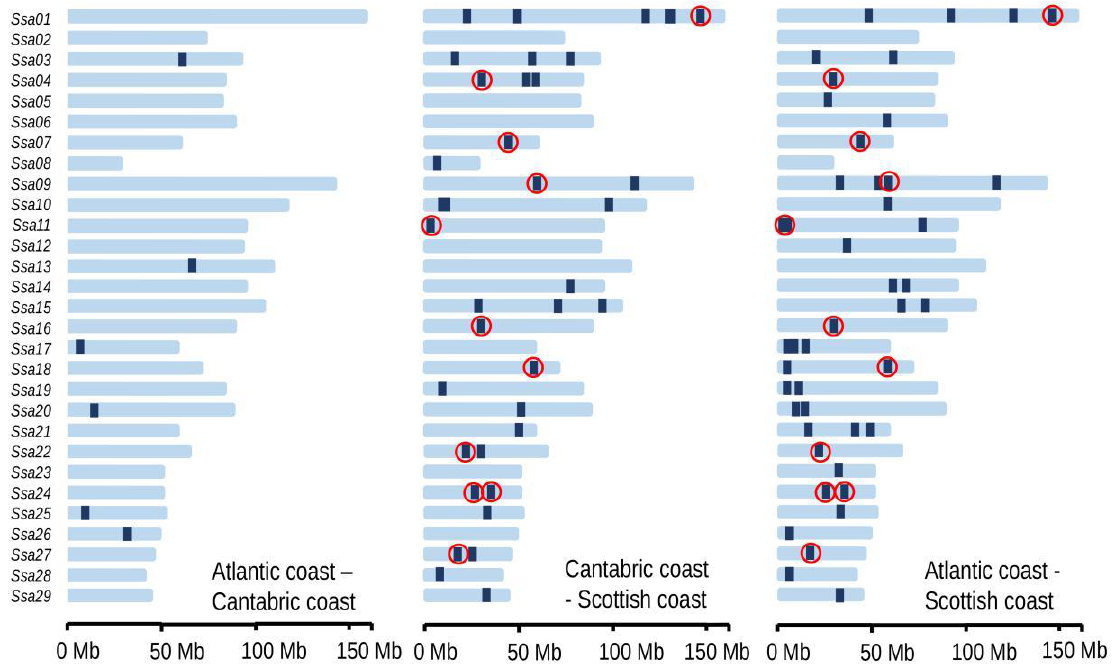
Figure 5. Per chromosome regions with significant SNPs obtained from at least two haplotype-based methods. Regions surrounded by a red circle indicate SNPs detected in both comparisons with Scotland. Table 3. Number of significant SNPs in at least two haplotype-based methods for each comparison.